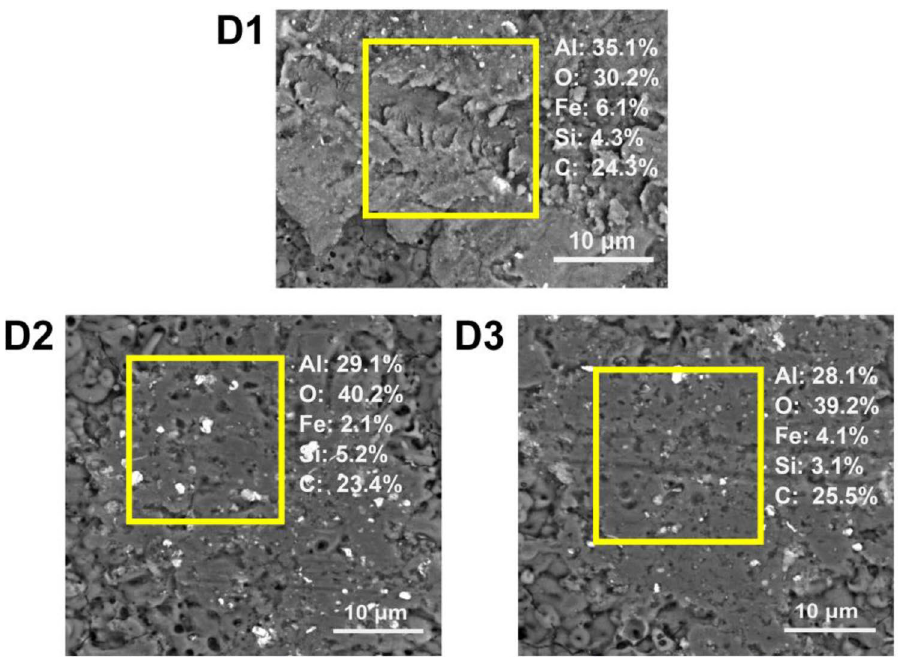
Figure 11. Partial worn surfaces and EDS results of the coatings ( D1 ): the coating without NCNs, ( D2 ): the coating with 1.2 g/L NCNs, ( D3 ): the coating with 1.6 g/L NCNs; Adobe Illustrator CS5, https:// www. adobe. com/ cn/ produ cts/ illus trator. html#